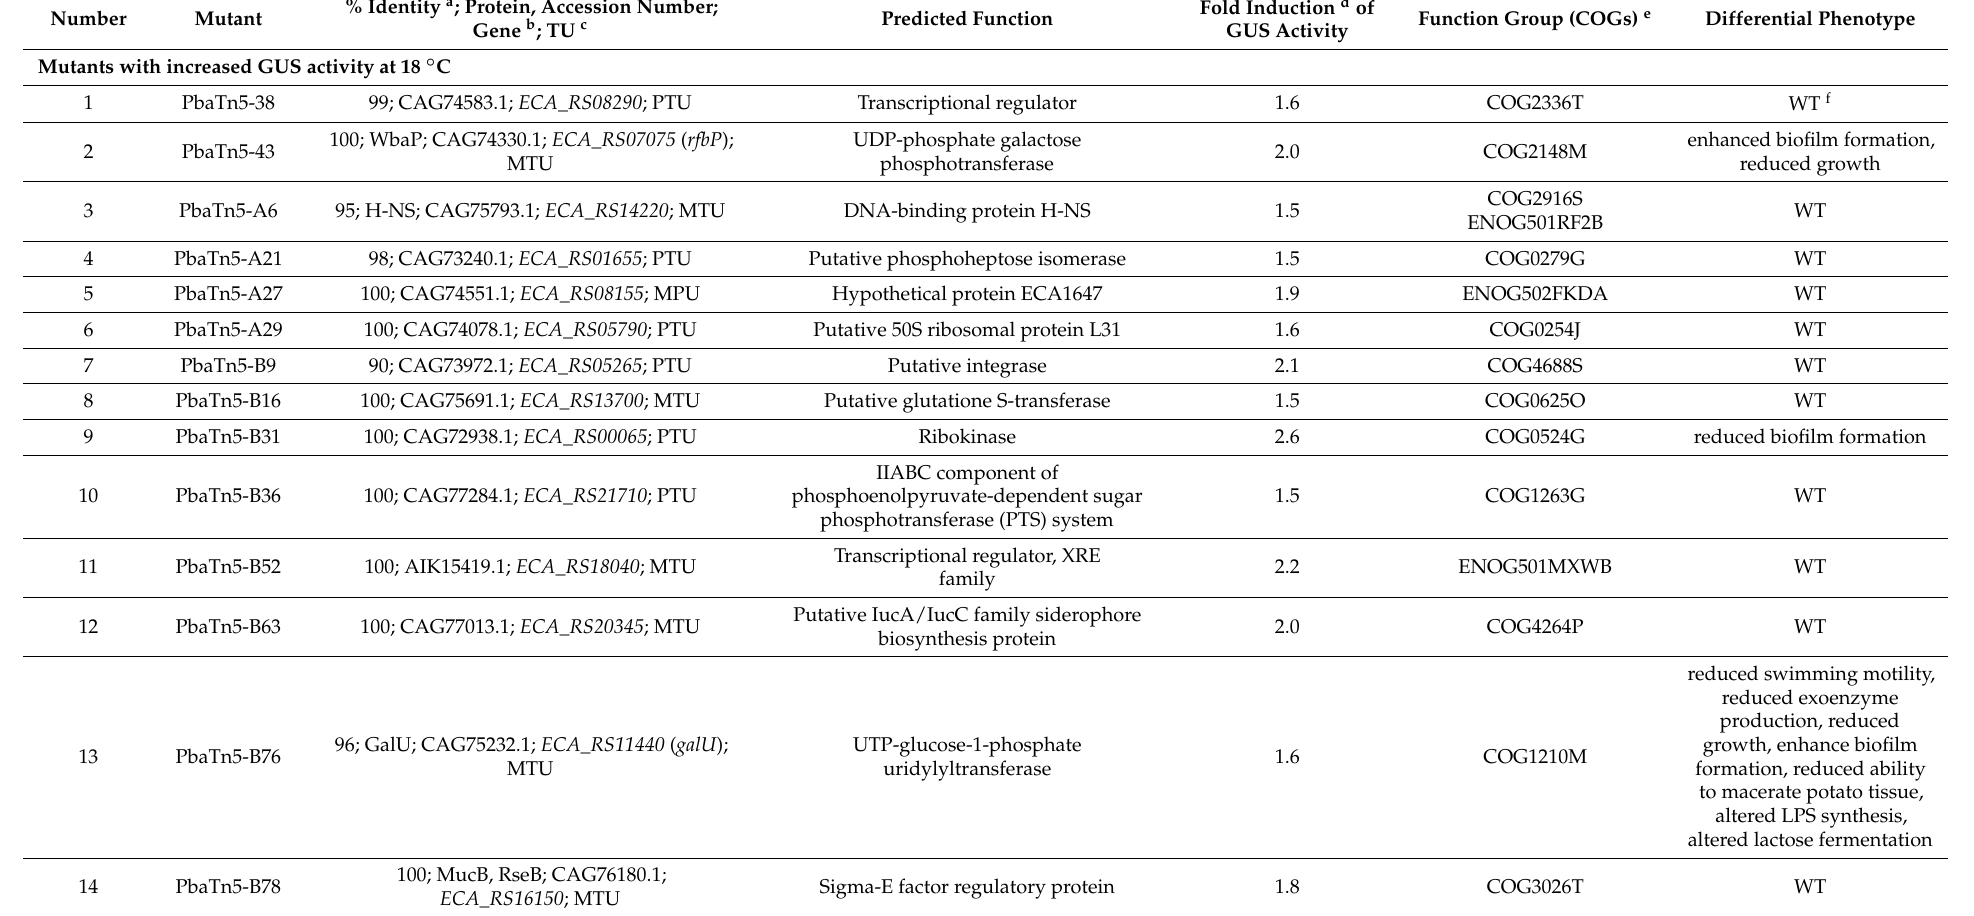
Table 1. Description of thermoresponsive loci of P. atrosepticum SCRI1043 transposon